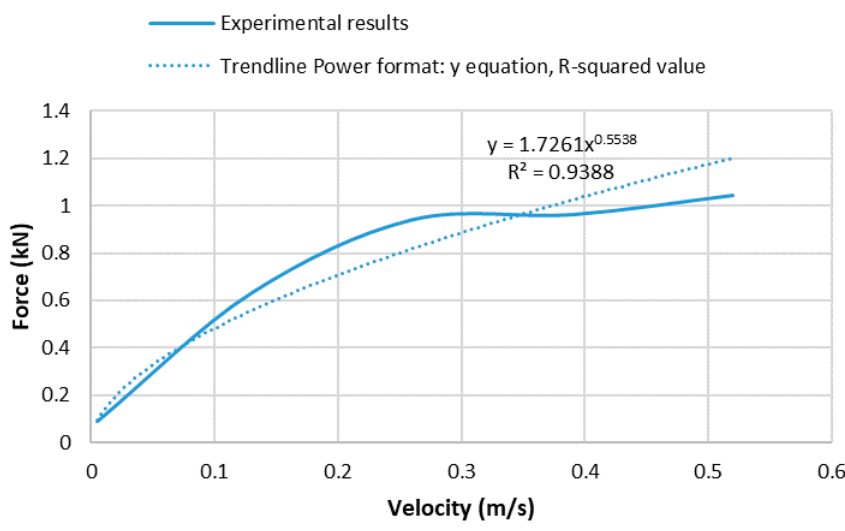
Figure 4. Force vs. velocity.